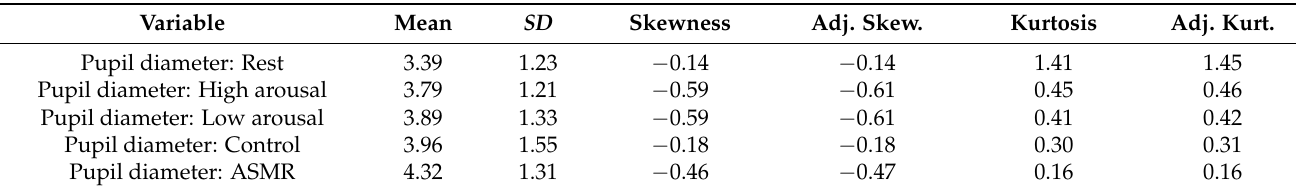
Table 2. Descriptive statistics of the pupil variables for each video. In the table, we report both the original and adjusted values for skewness and kurtosis [37].